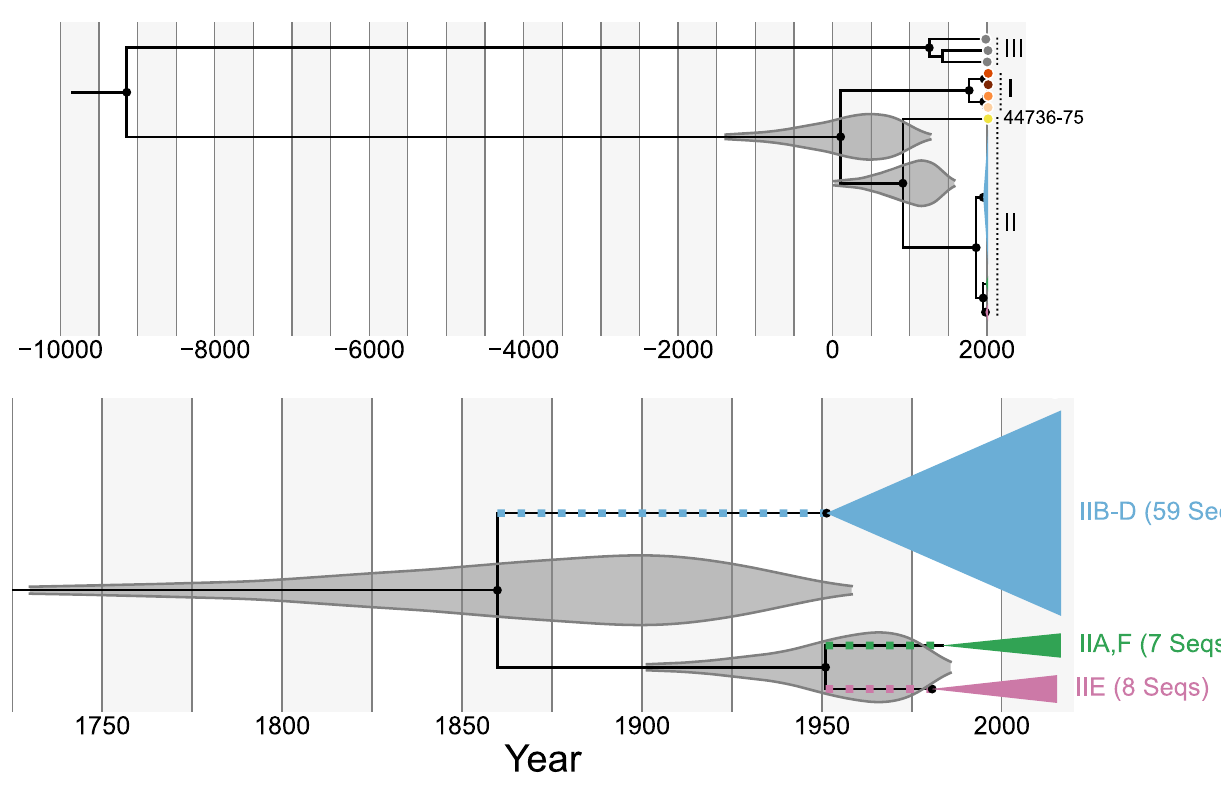
Fig 3. All 79 strains of Ophidiomyces ophiodiicola from Clades I and II likely shared a common ancestor < 4,000 years ago. Time-structured Bayesian phylogeny based on an alignment of 50,624 base pairs of the mitochondrial genome and including all 82 Oo strains (see S1C Fig for an uncollapsed, maximum- likelihood version of the same phylogeny). The top panel shows the entire tree, along with the posterior probability distributions (95% HPD) for the tMRCAs of Clades I-II and Clade II (gray). The bottom panel shows just a portion of Clade II and the posterior probability distributions (95% HPD) for the tMRCAs of clonal lineages IID–IIF and IID–IIE. Colored squares indicate the branches on which we infer that clonal lineages IID–IIF were first introduced to North America. Nodes represent mean age estimates. Most of the Clade II strains have been collapsed to save space, and the colors and clade/clonal lineage names are identical to those used in Fig 1. Filled black circles indicate nodes with posterior support � 95. Data underlying this figure can be found in OSF: https://osf.io/ fmbh5/. HPD, highest posterior density; tMRCA, time of the most recent common